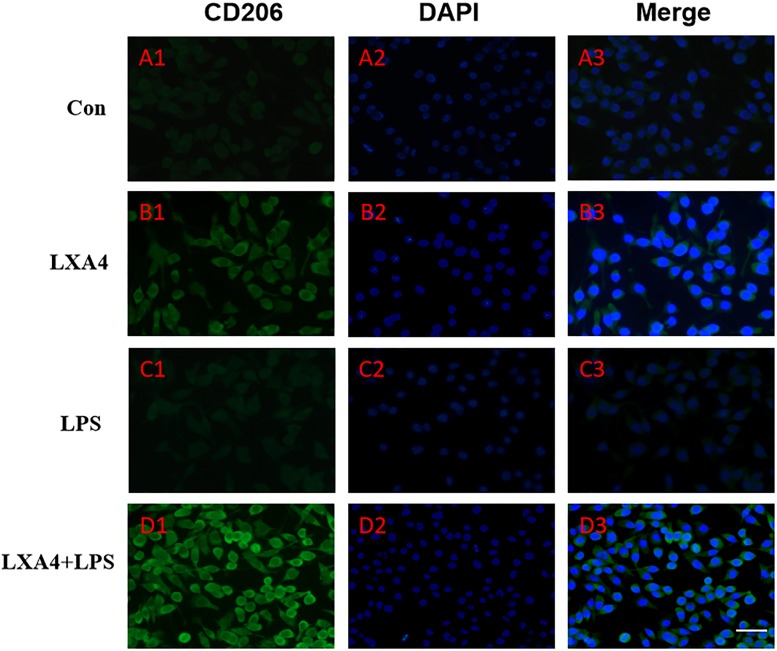
Immunofluorescence images showing the BV2 microglia after LPS stimulates which were not labeled with CD206 antibody, with LXA4, the expression of Arg1 is expressed at high level. Green fluorescence indicated CD206 positive cells, while blue fluorescence indicated DAPI-labeled nuclei. Scale bar: 20 μm.